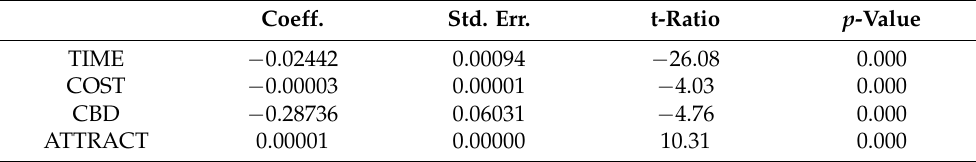
Table 1. Estimated parameters of mode and destination choice model (conventional). Coeff.